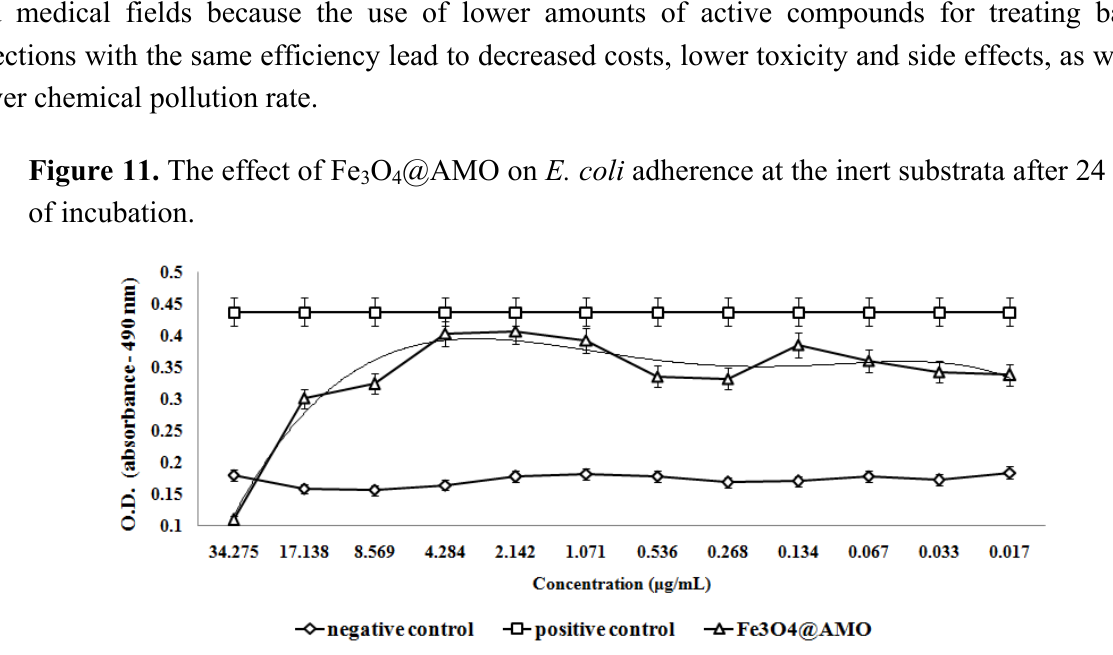
O @AMO on E. coli adherence at the inert substrata after 24 h 3 4